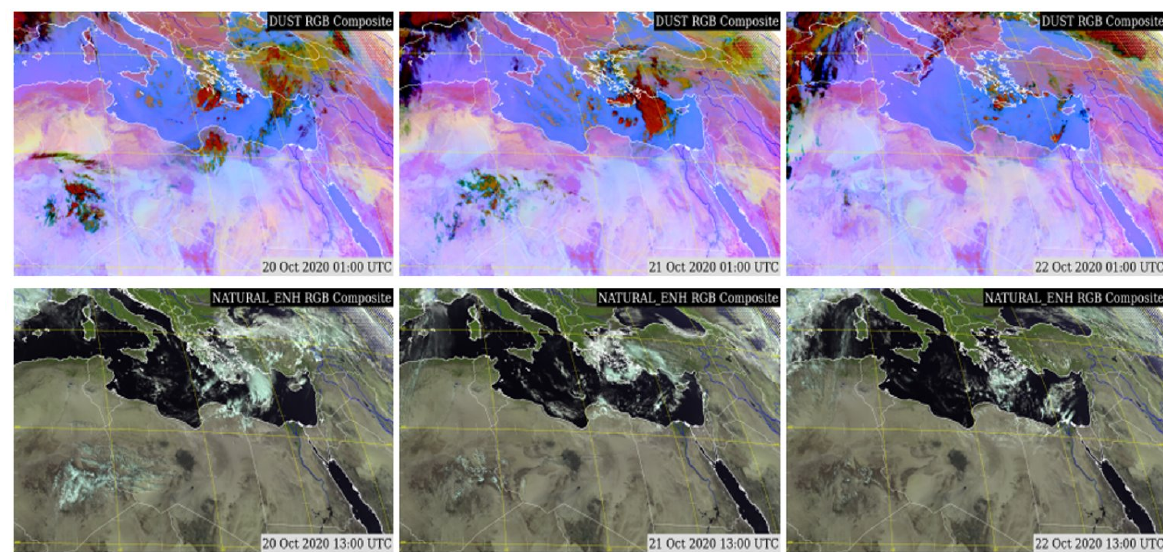
Figure A6. Representation of satellite imagery over Antikythera from 20–22 October, where in the top row the Dust RGB composite colour is shown for night-time imagery at 01:00:00UTC and in the bottom row the natural enhanced imagery is shown for 13:00:00UTC. The images of Fig. A6 are property of © EUMETSAT